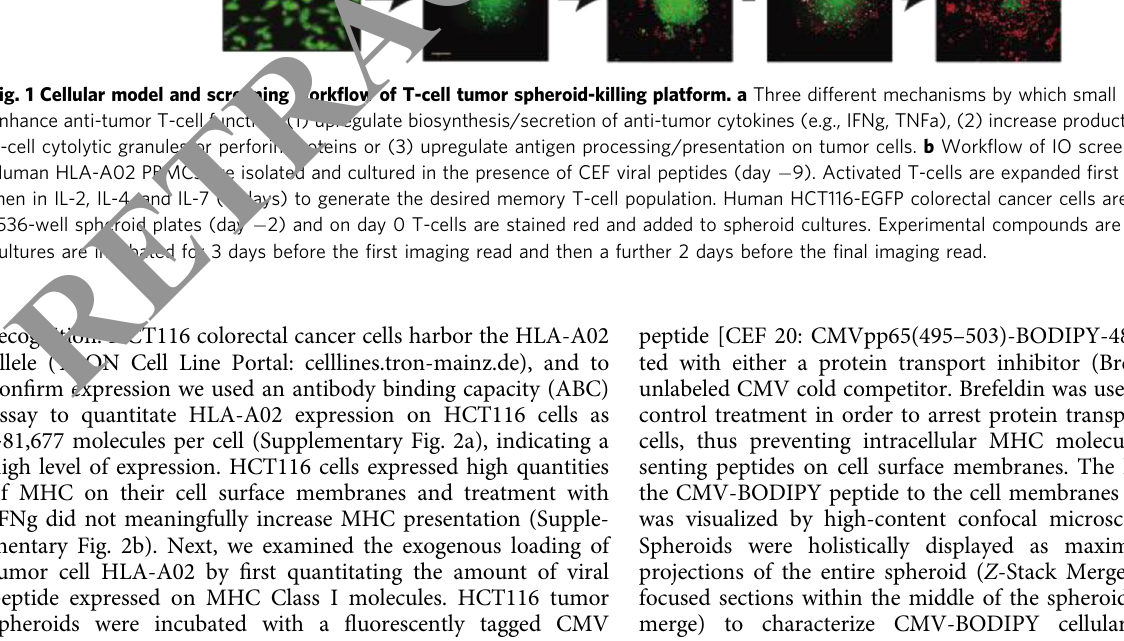
recognition. HCT116 colorectal cancer cells harbor the HLA-A02 allele (TRON Cell Line Portal: celllines.tron-mainz.de), and to con fi rm expression we used an antibody binding capacity (ABC) assay to quantitate HLA-A02 expression on HCT116 cells as ~81,677 molecules per cell (Supplementary Fig. 2a), indicating a high level of expression. HCT116 cells expressed high quantities of MHC on their cell surface membranes and treatment with IFNg did not meaningfully increase MHC presentation (Supple- mentary Fig. 2b). Next, we examined the exogenous loading of tumor cell HLA-A02 by fi rst quantitating the amount of viral peptide expressed on MHC Class I molecules. HCT116 tumor spheroids were incubated with a fl uorescently tagged CMV